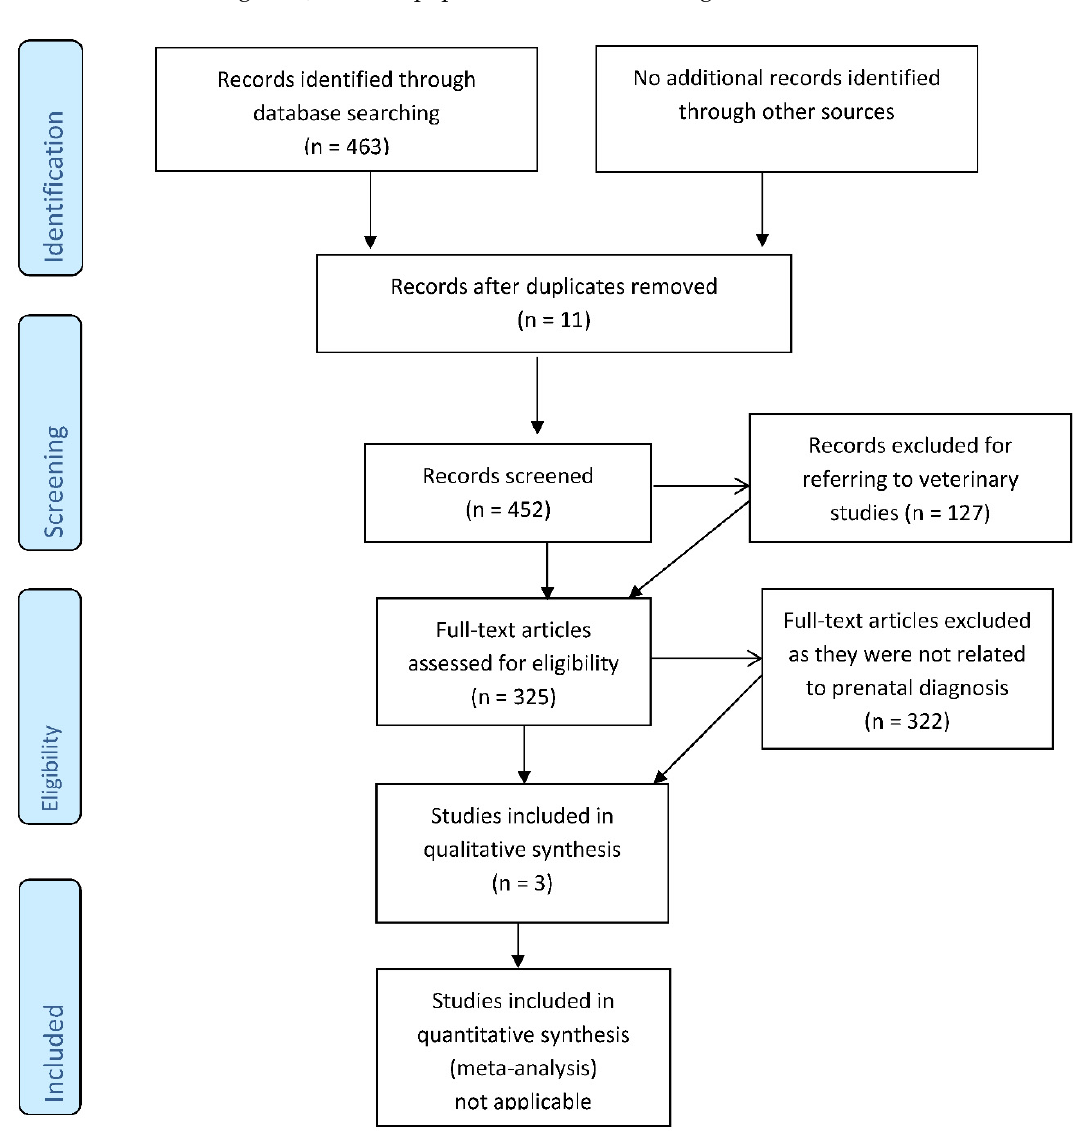
Figure 7. Flow diagram of the research.